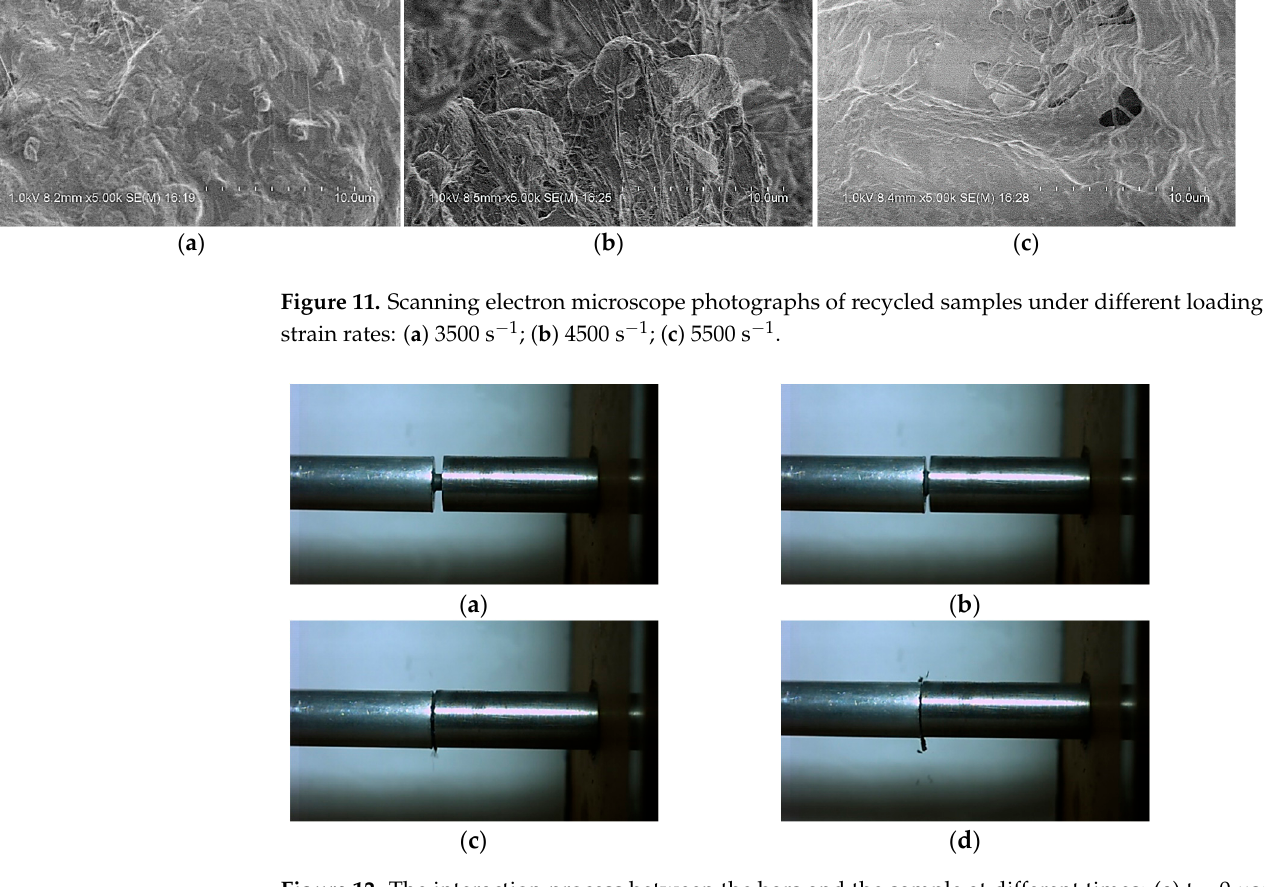
Figure 11. Scanning electron microscope photographs of recycled samples under different loading strain rates: ( a ) 3500 s − 1 ; ( b ) 4500 s − 1 ; ( c ) 5500 s − 1 .